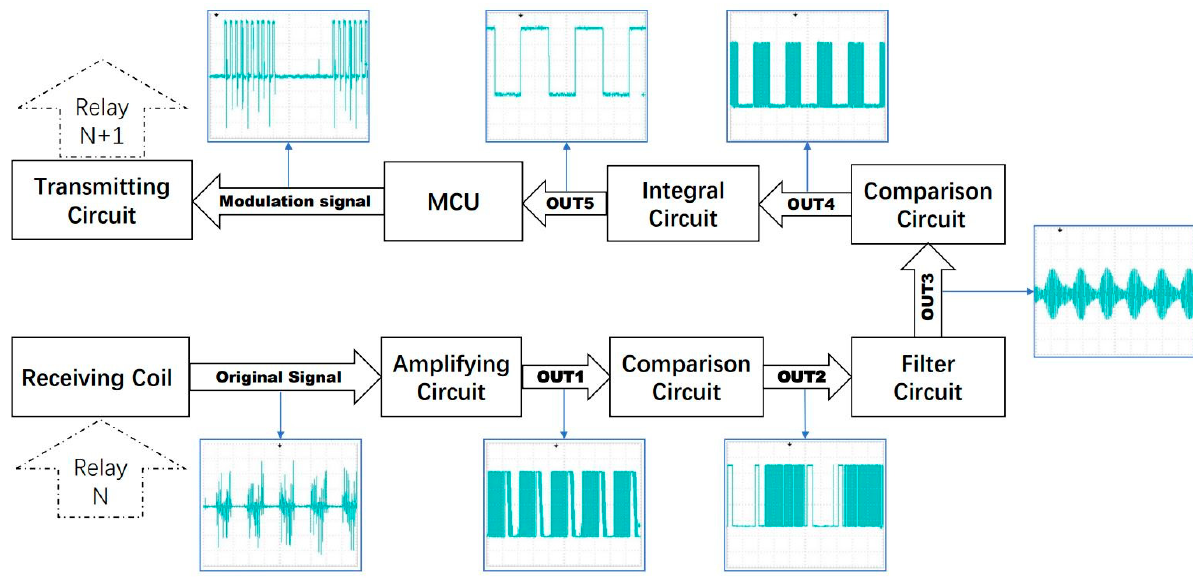
Figure 17. Signal processing flow chart.